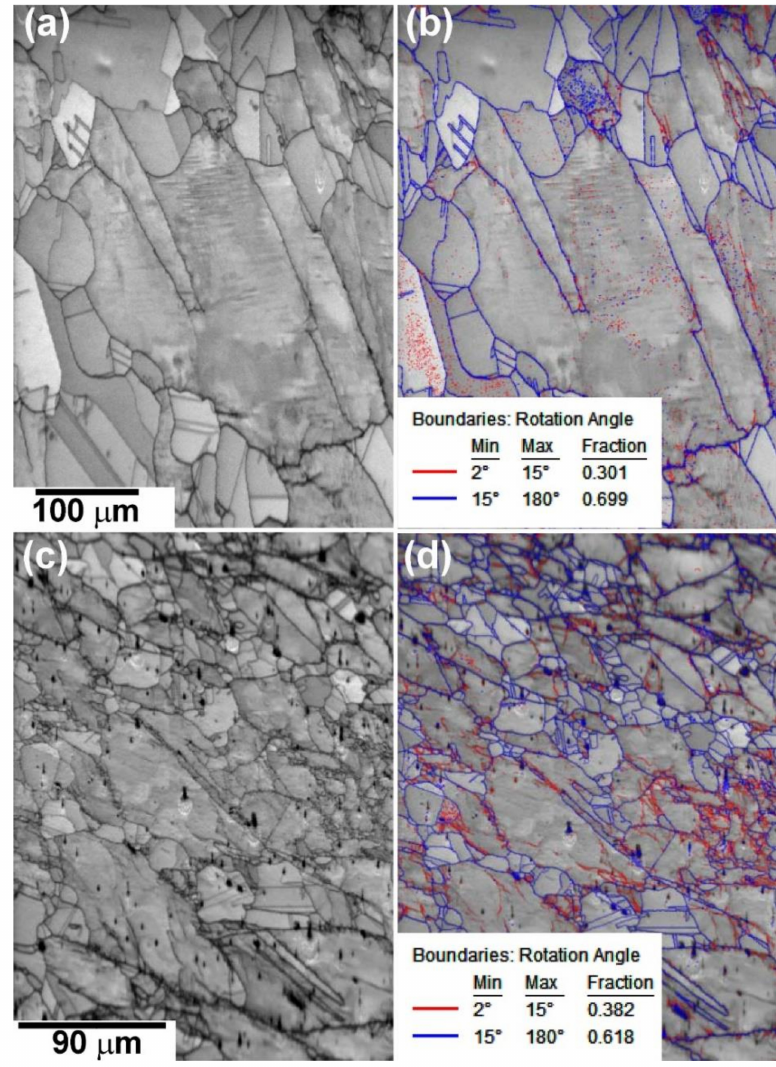
Figure 6. Electron backscatter di ff raction (EBSD) for samples quenched after the second pass with interpass time of 20 s: ( a , b ) for F138 steel; ( c , d ) for ISO steel (soaked at 1200 ◦ C). Image quality map: ( a , c ). Maps of the distribution of boundaries superimposed to respective image quality (IQ) images showing high-angle (misorientations θ > 15 ◦ , blue lines) and low-angle (subgrains, 2 ◦ < θ < 15 ◦ , red lines) grain boundaries: ( b , d ). Samples were water quenched immediately after the second pass